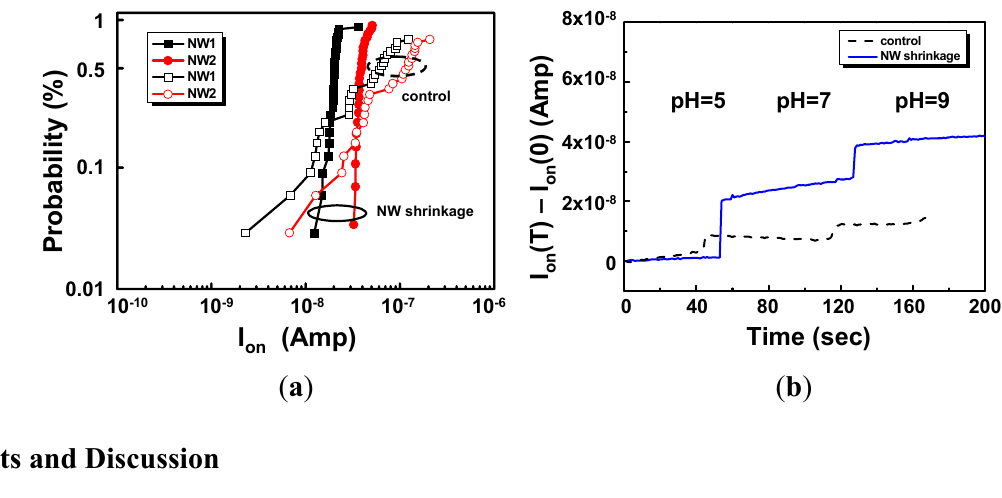
Figure 3. ( a ) The current distribution of various wire widths. The nanowire shrinkage technique can effectively improve the surface roughness-induced variability after PR trimming; ( b ) Real-time current data with sequential pH testing. The sensors of the nanowire shrinkage technique have more obvious pH